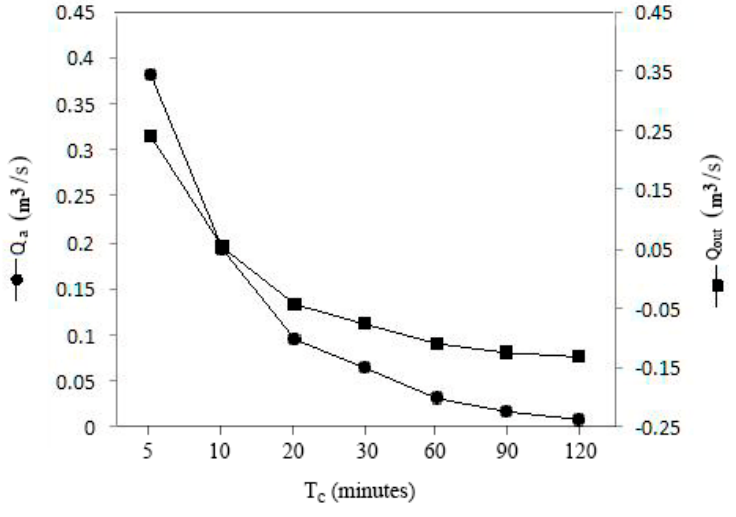
Figure 10. Comparison between input runoff ( Q a , left) and output runoff ( Q out , right) in m 3 /s.